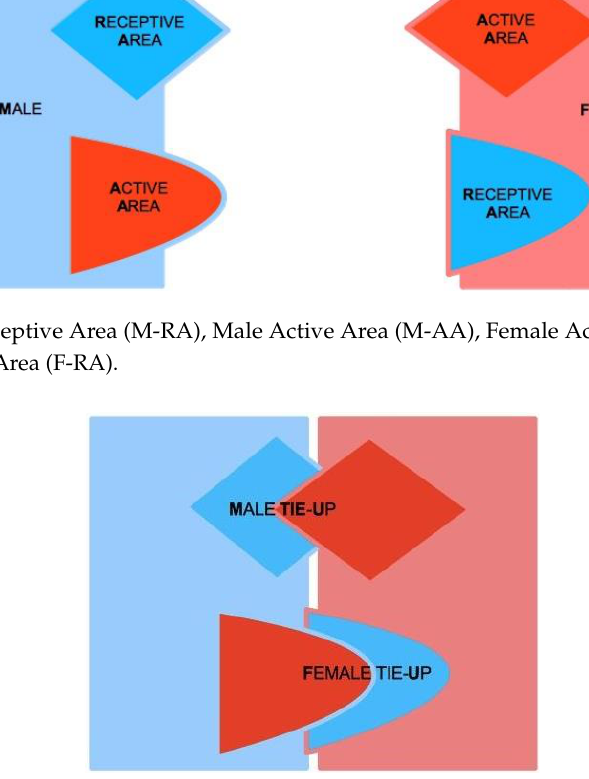
Figure 1. Male Receptive Area (M-RA), Male Active Area (M-AA), Female Active Area (F-AA), and Female Receptive Area (F-RA).